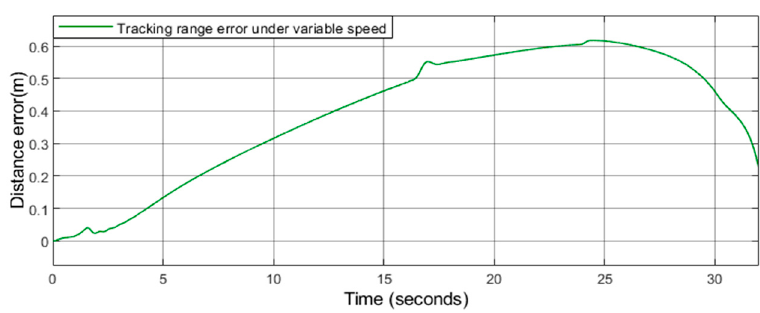
Figure 10. Tracking range error under variable speed.